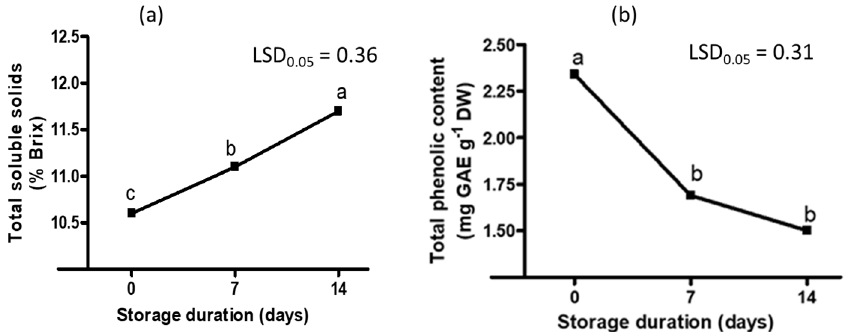
Figure 6. Effect of postharvest storage duration on sweet melon total soluble solids ( a ) and total phenolic content ( b ). Points on the line with different letters in each graph are significantly different at p ≤ 0.05 (Fisher’s protected LSD test, n = 3). GAE = gallic acid equivalent; DW = dry weight.